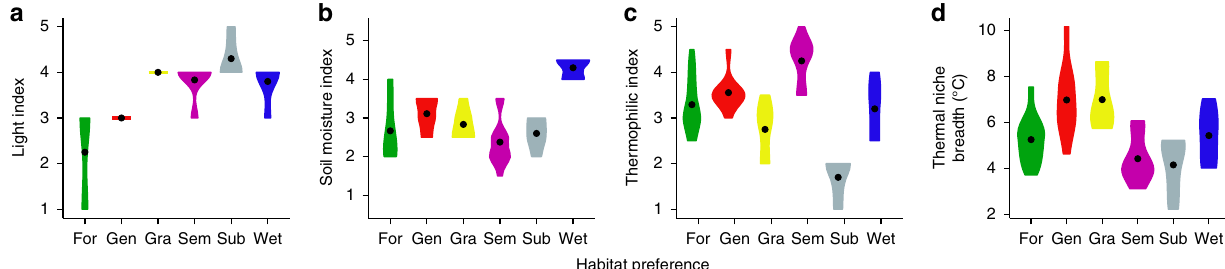
Fig. 2 Ecological characterization of habitat preference categories. Landolt ecological indicator values 60 for a light (from very shady: 1 to very bright: 5), b soil moisture (from very dry: 1 to fl ooded: 5), c temperature (from alpine: 1 to very warm: 5) and d realized breadth of the thermal niche in the study area based on annual mean temperature. Habitat preference categories: Forest (For), Generalist (Gen), Grassland (Gra), Semi-natural grassland (Sem), Subalpine (Sub), Wetland (Wet). Violin plots were drawn using the geom_violin() function with default settings in the ggplot2 package in R. Points represent